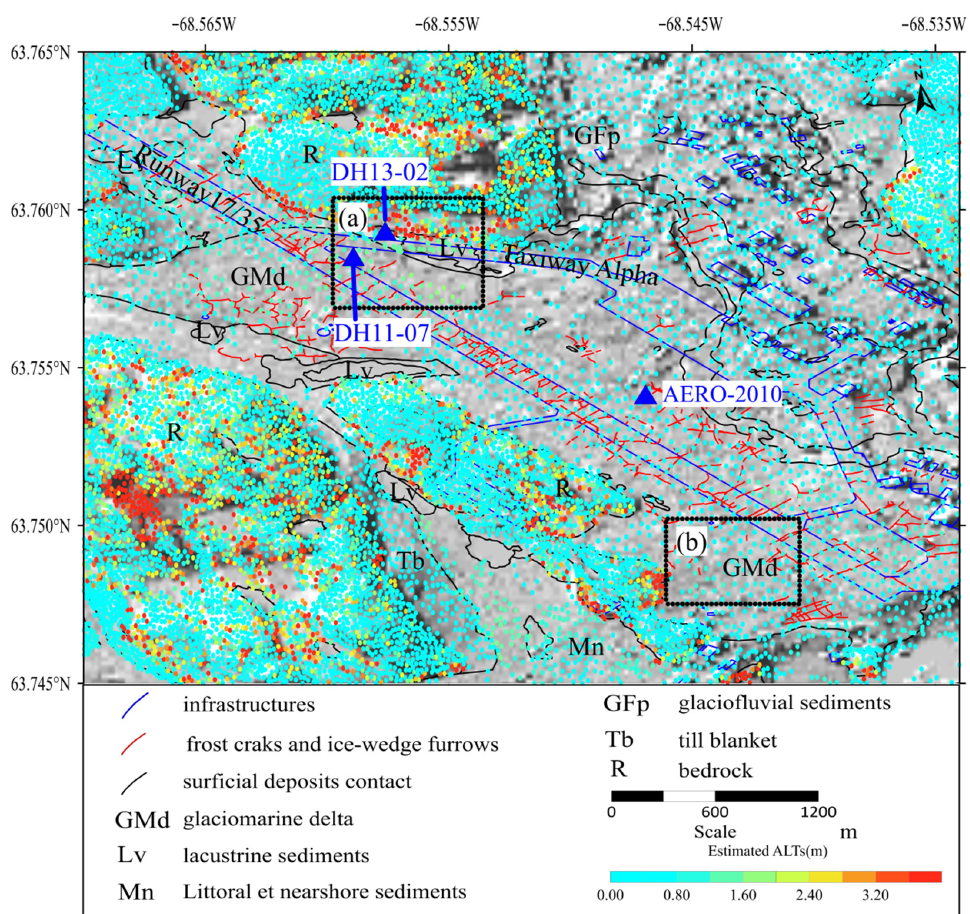
Figure 7. The ALT distribution in the airport sector. Blue triangles denote boreholes.